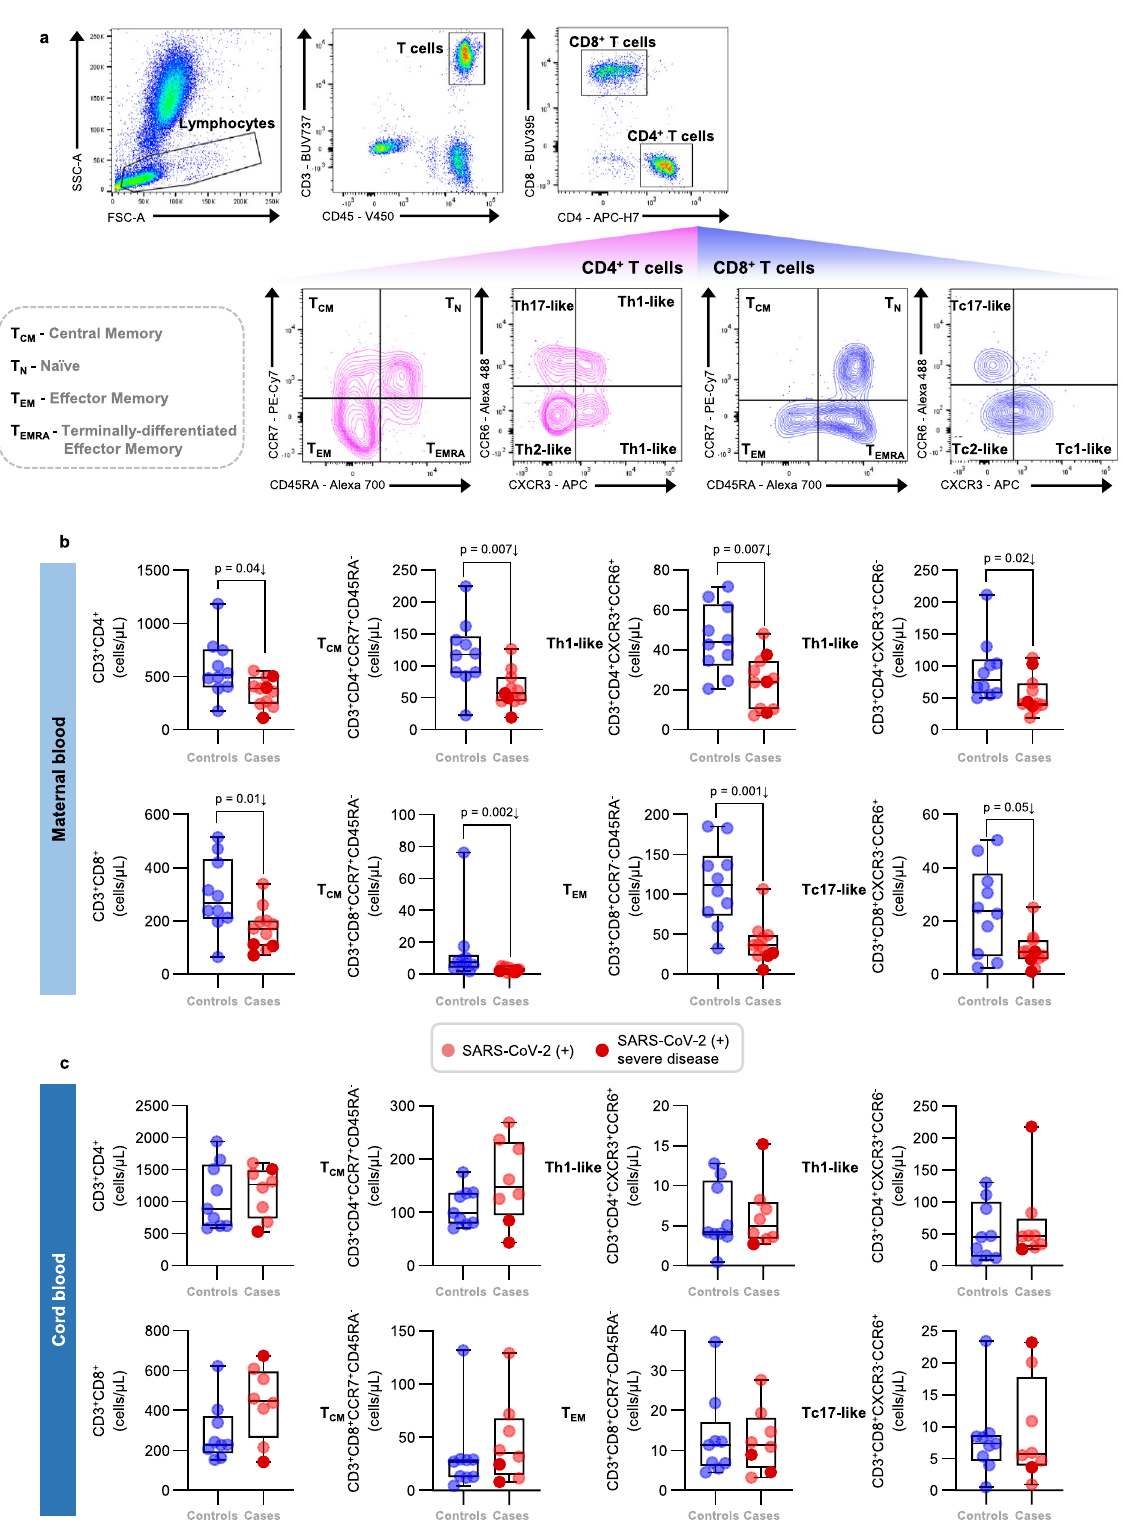
effects of SARS-CoV-2 infection on the maternal and neonatal immune system, we performed RNA-sequencing of maternal blood and cord blood from cases and controls (Fig. 6a). The transcriptomes of maternal and cord blood were correlated (Spearman ’ s ρ = 0.24; p < 0.001); therefore, some transcripts were shared between these two compartments (Fig. 6b). Yet, speci fi c non-shared genes were modulated in the